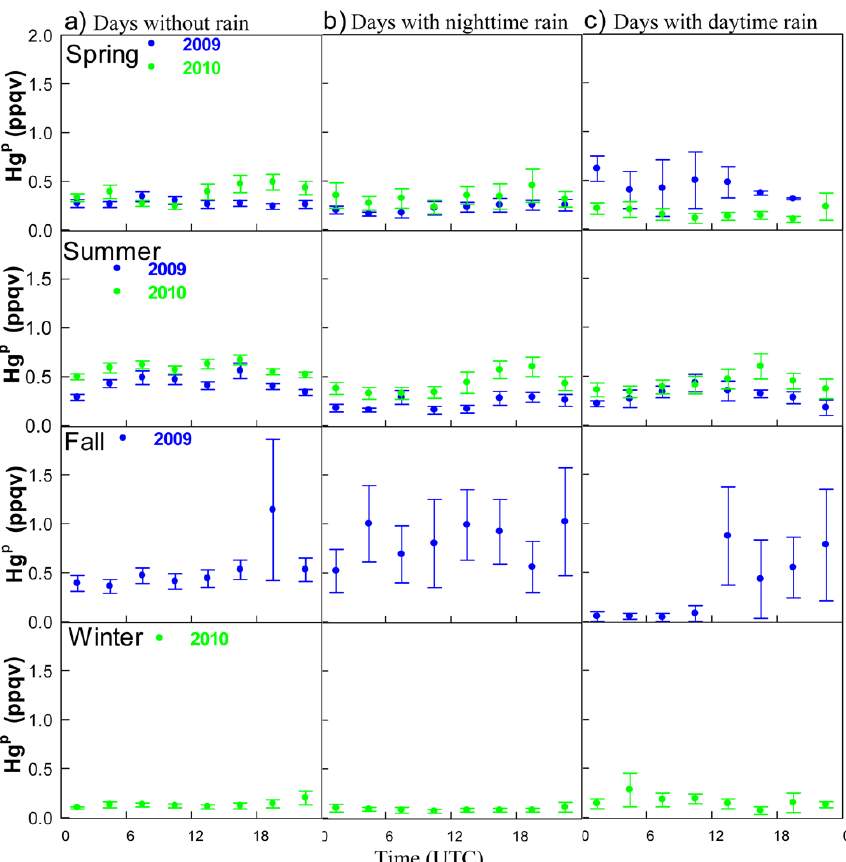
Fig. 18. Diurnal cycles of Hg P at AI (marine) averaged over days without rain (a) , days with nighttime rain (b) , and days with daytime rain (c) for all seasons during 2009–2010. Precipitation in winter includes rain and snow. Local nighttime is about 00:00–11:00UTC, daytime 12:00–23:00UTC, and noontime is 16:00UTC during the Daylight Saving period of the year and 17:00UTC